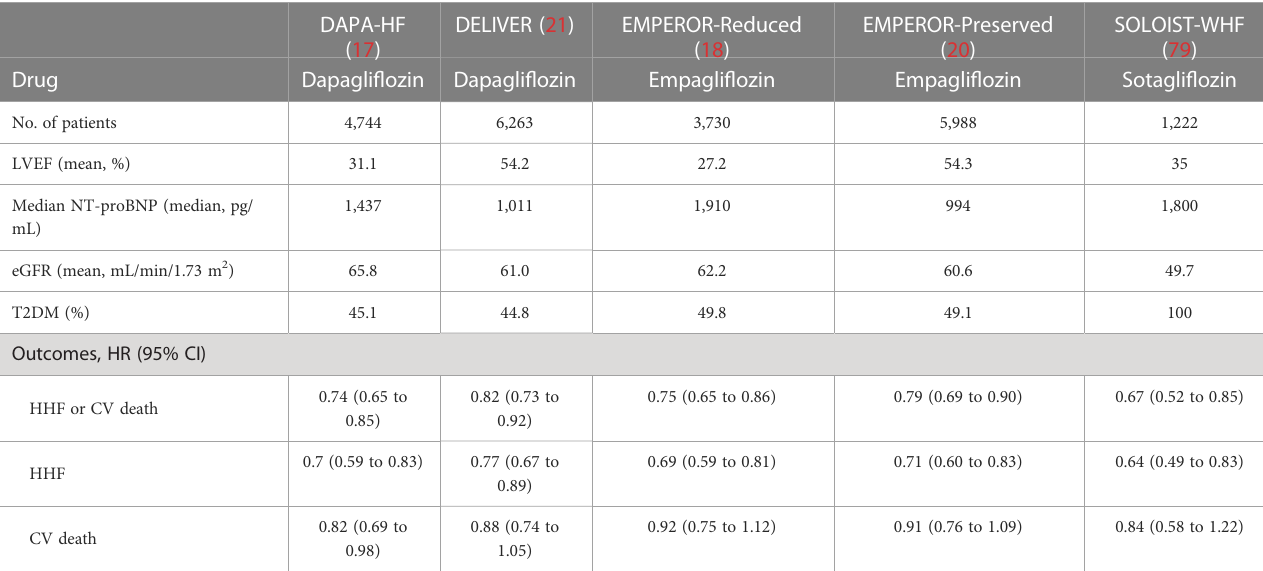
TABLE 3 Randomized controlled trials of patients with heart